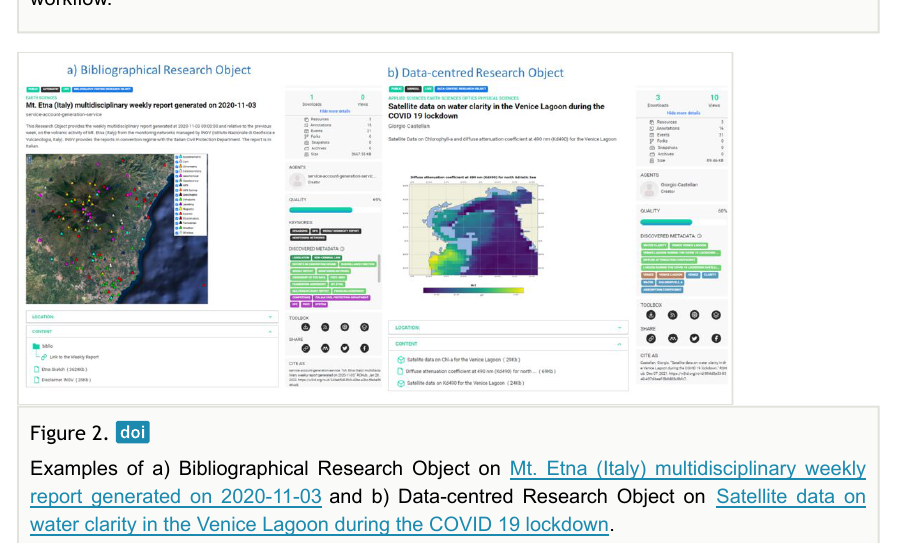
Examples of a) Bibliographical Research Object on Mt. Etna (Italy) multidisciplinary weekly report generated on 2020-11-03 and b) Data-centred Research Object on Satellite data on water clarity in the Venice Lagoon during the COVID 19